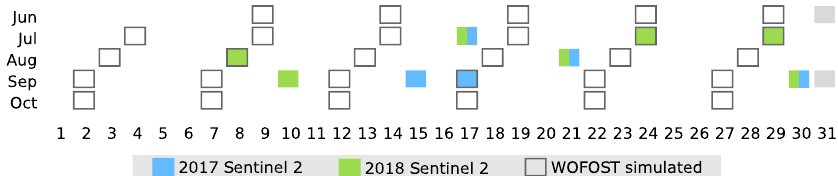
Figure 2. Acquisition dates of satellite images and dates of leaf area index (LAI) images simulated with the WOrld FOod STudies (WOFOST) model.